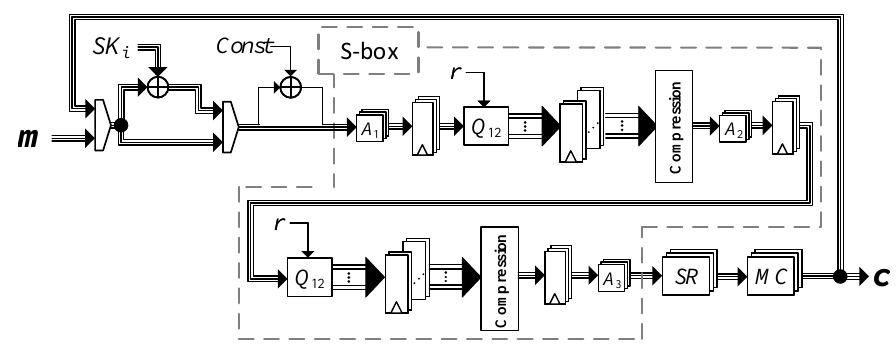
Figure 5: Design architecture of our round-based second-order LED-128 encryption function.